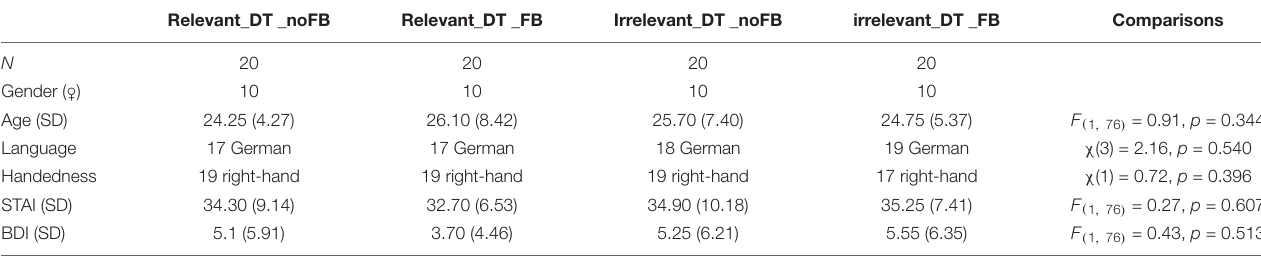
TABLE 1 | Descriptive statistics of the four